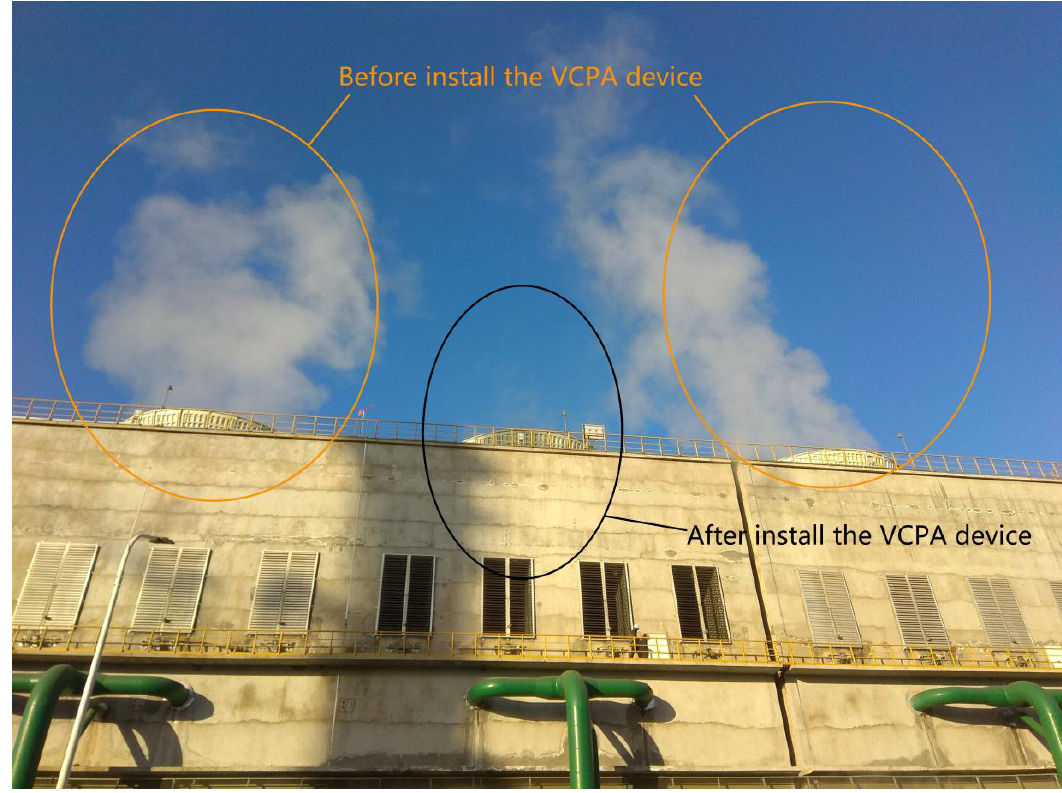
ff ect of plume